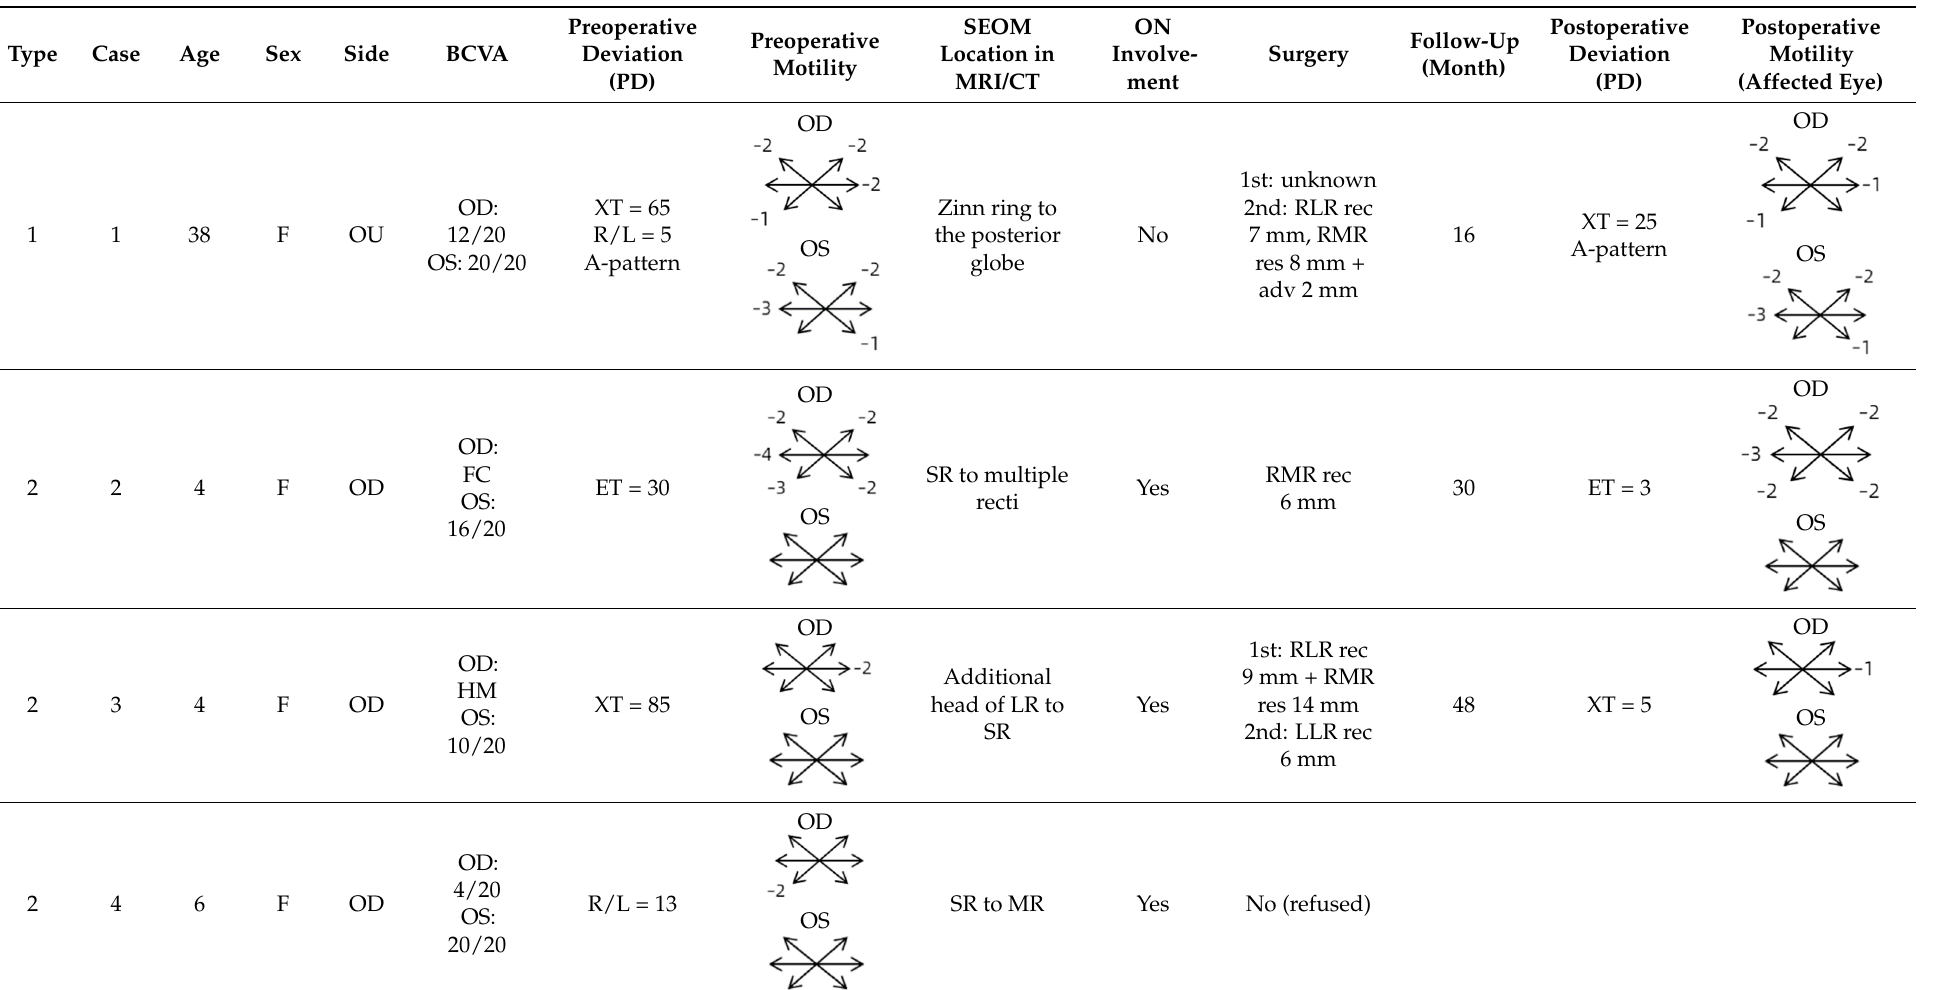
Table 1. Clinical characteristics and surgical results in 12 patients with supernumerary extraocular muscle.